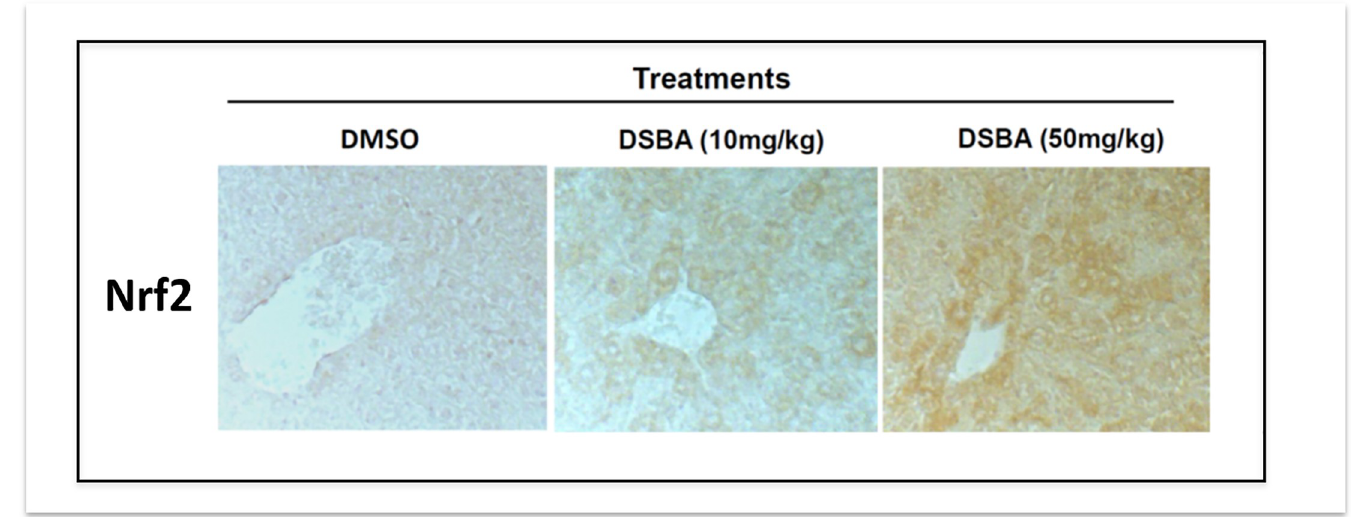
Fig 2. DSBA activates Nrf2 in liver tissues in vivo . IHC was employed to assess Nrf2 expression in liver tissues of C57 BL/6 mice at 24 h after drug treatment. Magnification 400x. Vehicle control = DMSO.